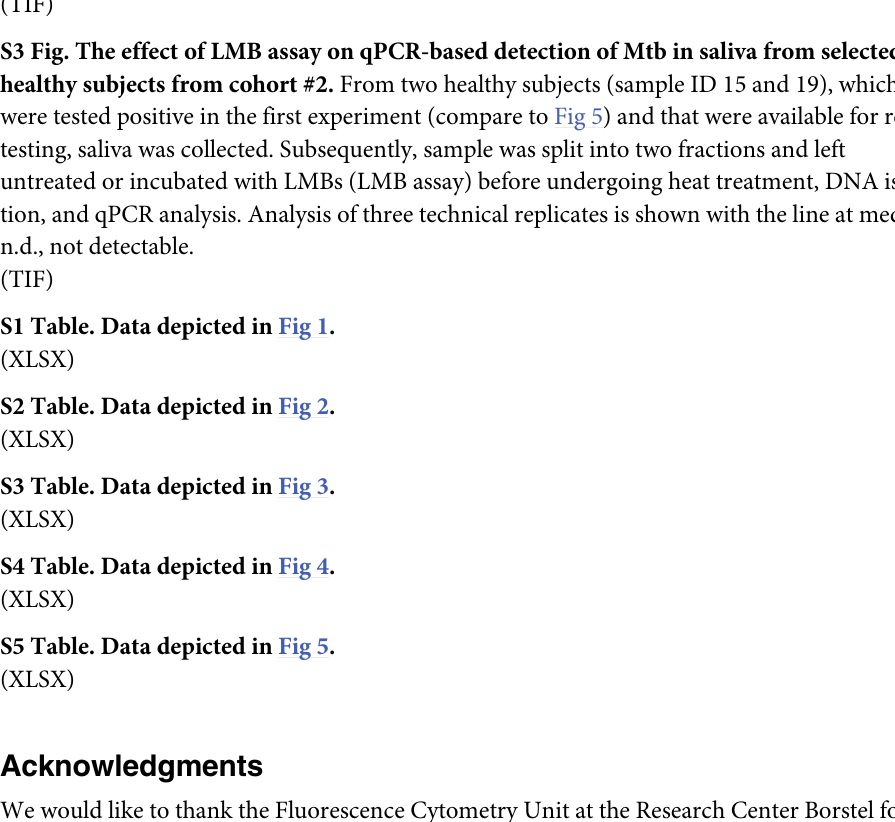
S1 Fig. Standard curve for the conducted qPCR to detect Mtb DNA. After DNA extraction, two-fold serial dilutions were analysed by qPCR detecting a region in Rv2819 from Mtb. A simple linear regression was conducted, revealing the efficiency of this qPCR reaction (E = 1.77, 77%). Using this standard curve, the (relative) DNA concentration of unknown sam- ples (based on their ct-values) was calculated based on the formula Y(Ct) = -3,998 � X(log(con- centration) + 33,56. Obtained relative DNA concentrations were used to estimate the fold enrichment of Mtb DNA in LMB assay treated samples as given in the main text. S2 Fig. Effect of proteinase K / DTT treatment on Mtb viability. The indicated concentra- tion of Mtb H37Rv was incubated in the absence and presence of Proteinase K (18U/ml) plus DTT (2mM) for 1h at 37˚C. Colony forming units were determined as described in Material and Methods . Statistical analysis using an U-Test comparing control (PBS) and Proteinase K +DTT treated samples showed no significant differences between the groups (p = 0.3753). Line at each condition indicates the median of 3 independent experiments. S3 Fig. The effect of LMB assay on qPCR-based detection of Mtb in saliva from selected healthy subjects from cohort #2. From two healthy subjects (sample ID 15 and 19), which were tested positive in the first experiment (compare to Fig 5) and that were available for re- testing, saliva was collected. Subsequently, sample was split into two fractions and left untreated or incubated with LMBs (LMB assay) before undergoing heat treatment, DNA isola- tion, and qPCR analysis. Analysis of three technical replicates is shown with the line at median. n.d., not